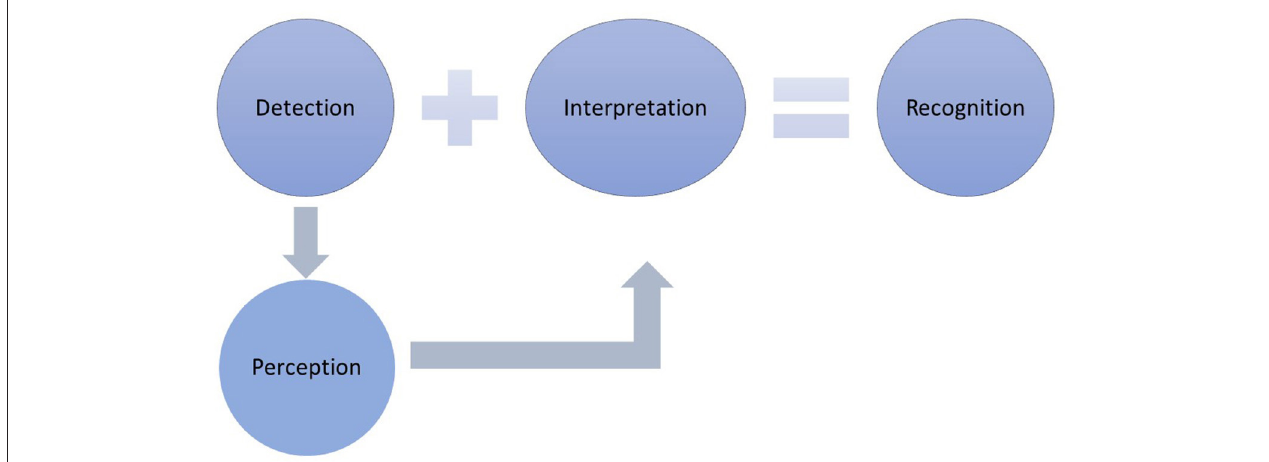
FIGURE 1 | The response to symptoms requires that the symptom is detected, presumably through the behaviors of self-care monitoring. Monitoring involves actively noticing typical symptoms and checking for the presence of bodily changes. Symptom detection precedes perception, which involves becoming consciously aware of the symptom. Once detected and perceived, interpretation and the assignment of meaning occurs, which leads to symptom recognition. Symptom recognition is required before a self-care management response can be expected to